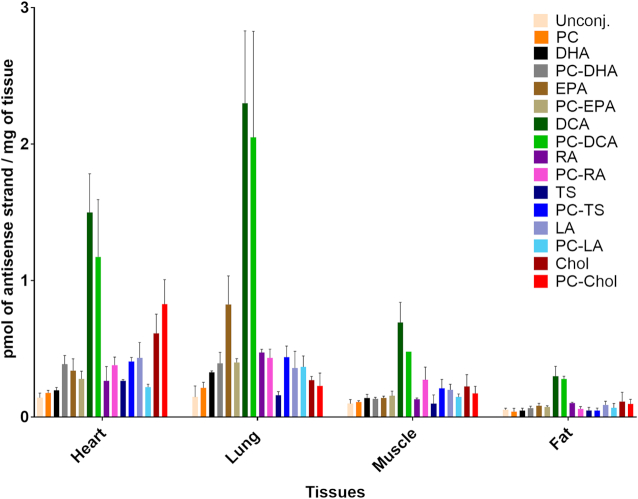
Conjugated siRNAs accumulate into extra-hepatic tissues, accumulation defines by the structure of the conjugate. Bar graph showing the quantity of the antisense strand of conjugated siRNAs present in heart, lung, muscle and fat 48 h after a single subcutaneous injection with 20 mg/kg (n = 3 mice per conjugate ± SD). siRNA quantification was measured by PNA hybridization assay. DCA and PC-DCA conjugates improve extra-hepatic siRNA accumulation compared to cholesterol.